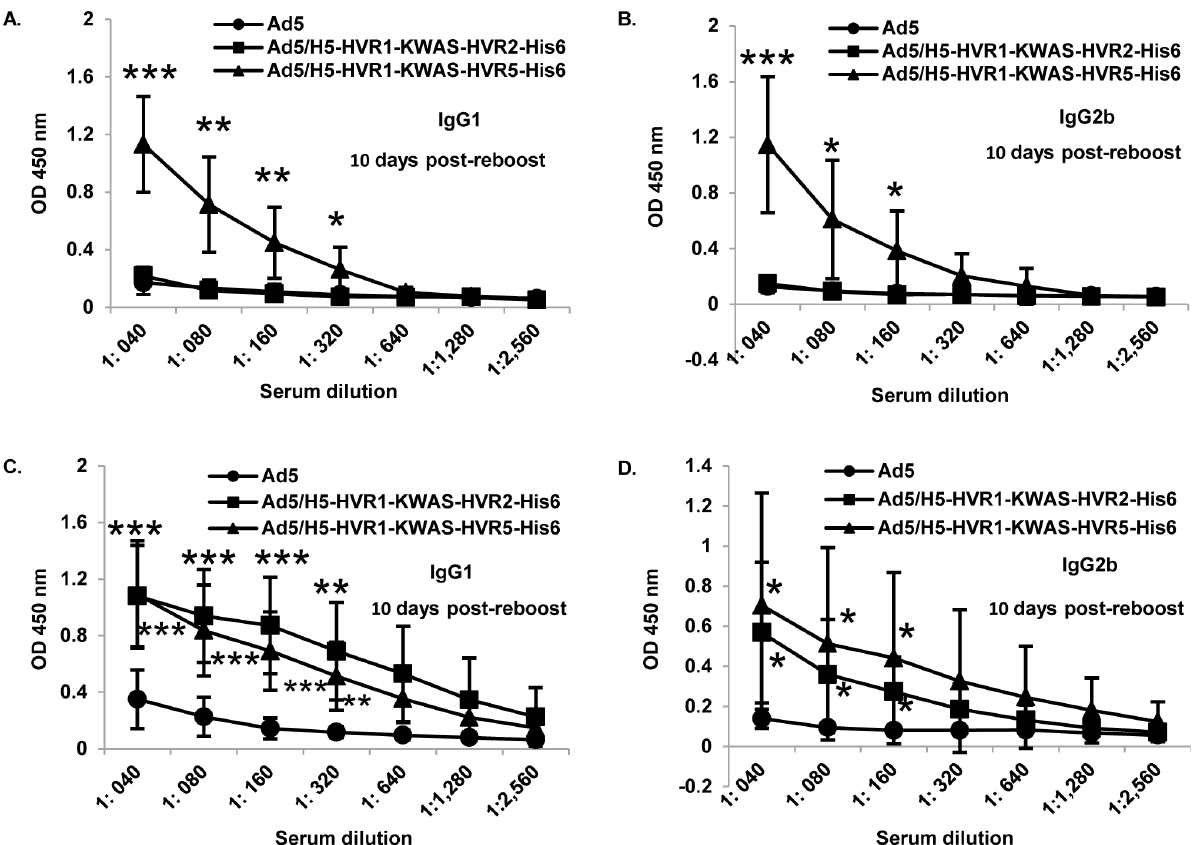
Figure 6. Multivalent vectors elicit invivo His 6 and KWAS isotype-specific responses. BALB/c mice (n=8) were primed, boosted, and reboosted with 1 6 10 10 VP of Ad vectors (Figure 4A). 10 days post-reboost serum was used for the isotype-specific assays. A–B) 1 m M of purified His 6 (LGSHHHHHHLGS) antigenic peptide or C–D) 1 m M of purified KWAS (PCEWDEAELDKWASNLEEEDDDNE) antigenic peptide was bound to ELISA plates. Residual unbound peptide was washed from the plates. The plates were then incubated with immunized mice serum followed by isotype-specific antibodies. The binding was detected with HRP conjugated secondary. OD at 450 nm represents isotype-specific His 6 or KWAS antibody levels in sera. The values are expressed as the mean 6 standard deviation. The *** indicate a P value # 0.001, ** indicate a P value # 0.01, and * indicate a P value # 0.05.